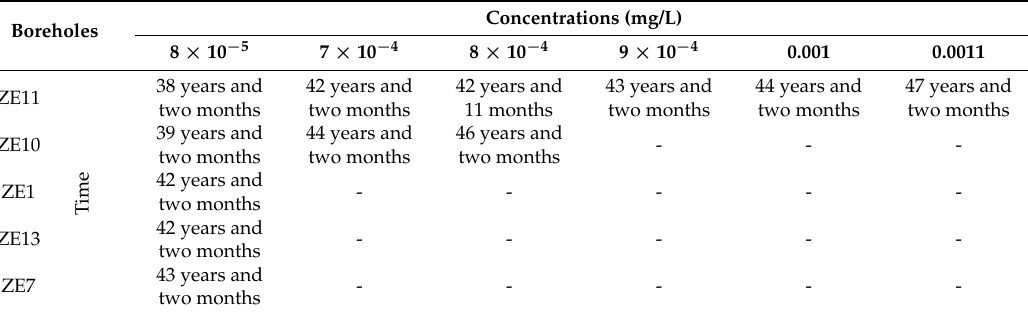
Table 6. Overall time of transport of dissolved